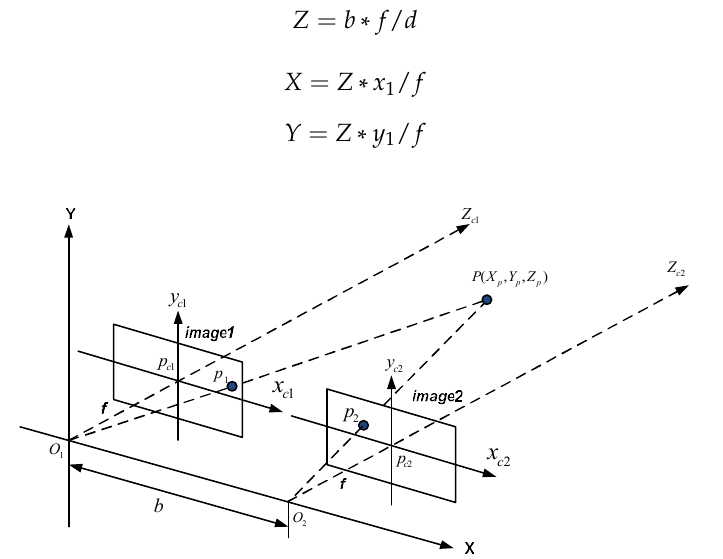
Figure 1. Configuration scheme of stereo vision.